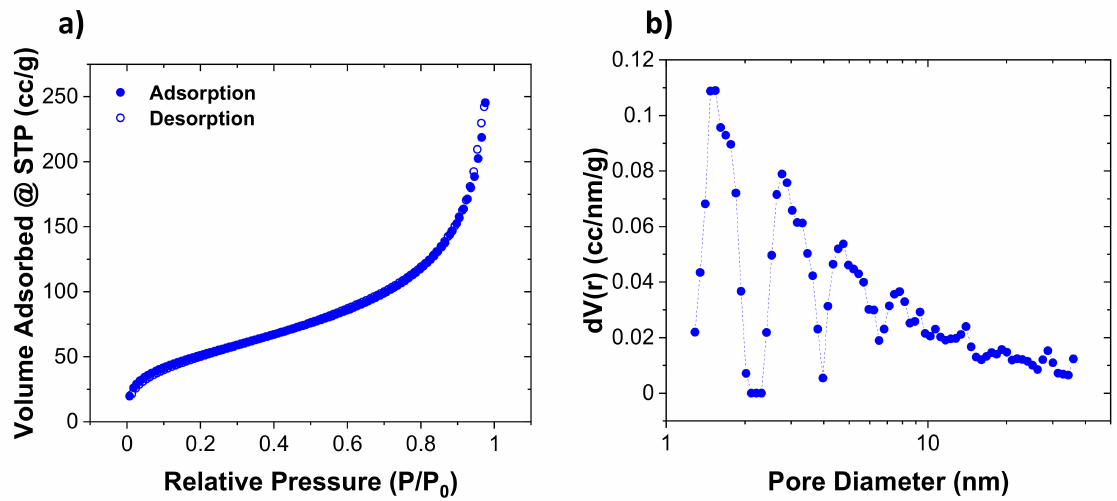
Figure 4. Surface area and pore size distribution measurements of a hollow silica particle sample by using N 2 adsorption- desorption isotherms and density functional theory (DFT). ( a ) N 2 adsorption-desorption isotherms and ( b ) the extracted pore size distributions of the SiO 2 sample by using density functional theory